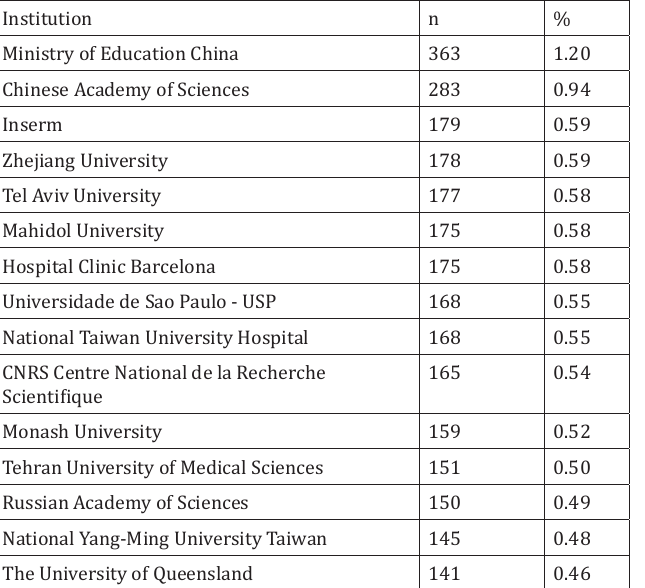
The List of Top 10 Journals Contributing the Acinetobacter Literature (n=30074).